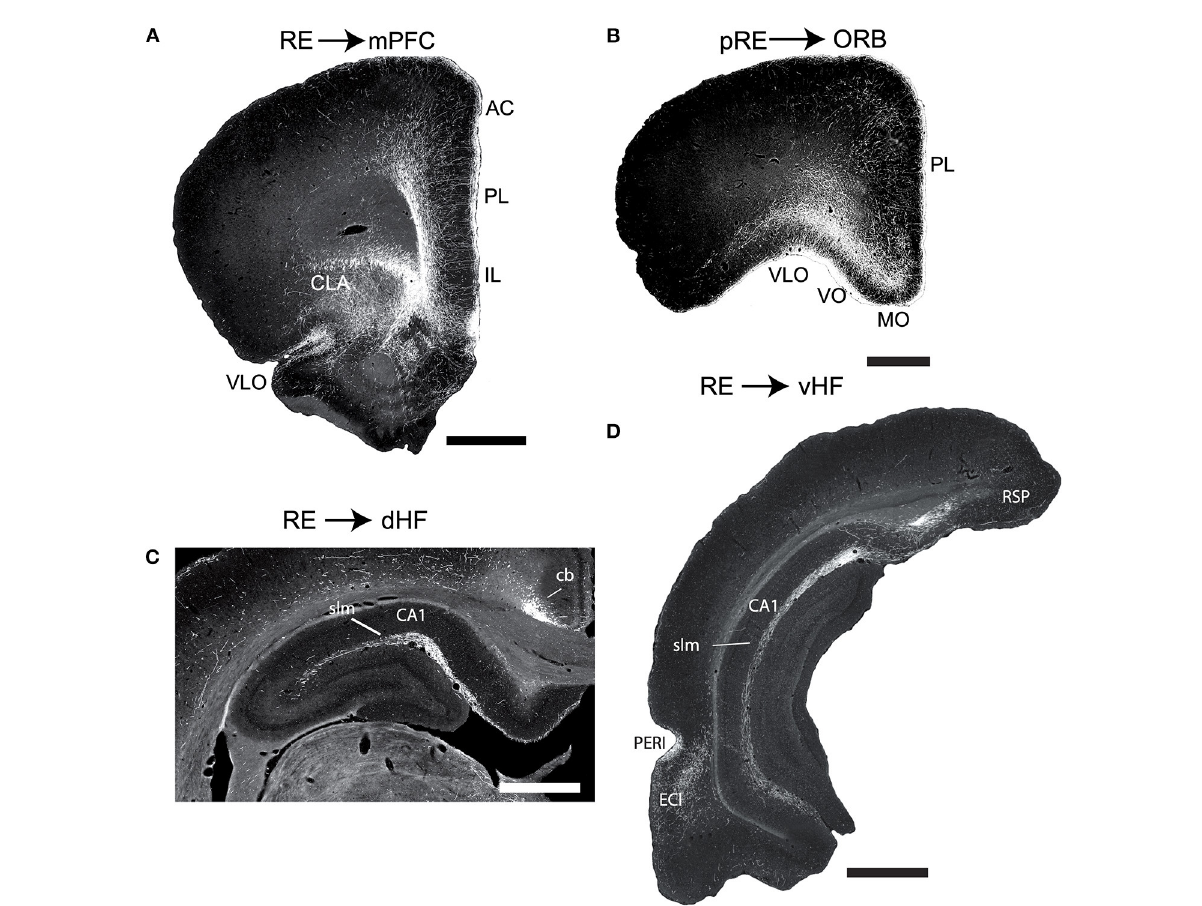
FIGURE3 (A,B) Low magnification darkfield micrographs of transverse sections through the forebrain depicting the pattern of labeling in the medial prefrontal cortex (mPFC) (A) and the orbital cortex (ORB) (B) in the rat produced by anterograde tracer injections in the nucleus reuniens (RE) and peri-reuniens (pRE), respectively, of the ventral midline thalamus. (A) Note the dense collection of labeled fibers in the anterior cingulate (AC), prelimbic (PL) and infralimbic (IL) cortex of the mPFC, most concentrated in layers 1 and 5/6. (B) Note the dense labeling extending mediolaterally across ORB, heavily concentrated in the medial (MO) and ventral (VO) divisions of the ORB. (C,D) Low magnification darkfield micrographs of transverse sections through the dorsal (C) and ventral hippocampus (D) depicting patterns of labeling following anterograde tracer injections (PHA-L) in the nucleus reuniens. Note the dense collection of labeled fibers in the stratum lacunosum moleculare (slm) of CA1 of the dorsal (C) and ventral hippocampus and in molecular layer of the ventral subiculum (SUBv) (D) . Scale bar for (A,D) = 1000 µ m; for (B) = 750 µ m; for (C) = 600 µ m. Abbreviations: cb, cingulum bundle; CLA, claustrum; DLO, dorsolateral orbital cortex; ENTl, lateral entorhinal cortex; PERI, perirhinal cortex; RSP, retrosplenial cortex; VLO, ventrolateral orbital cortex. Figure modified from Vertes et al.